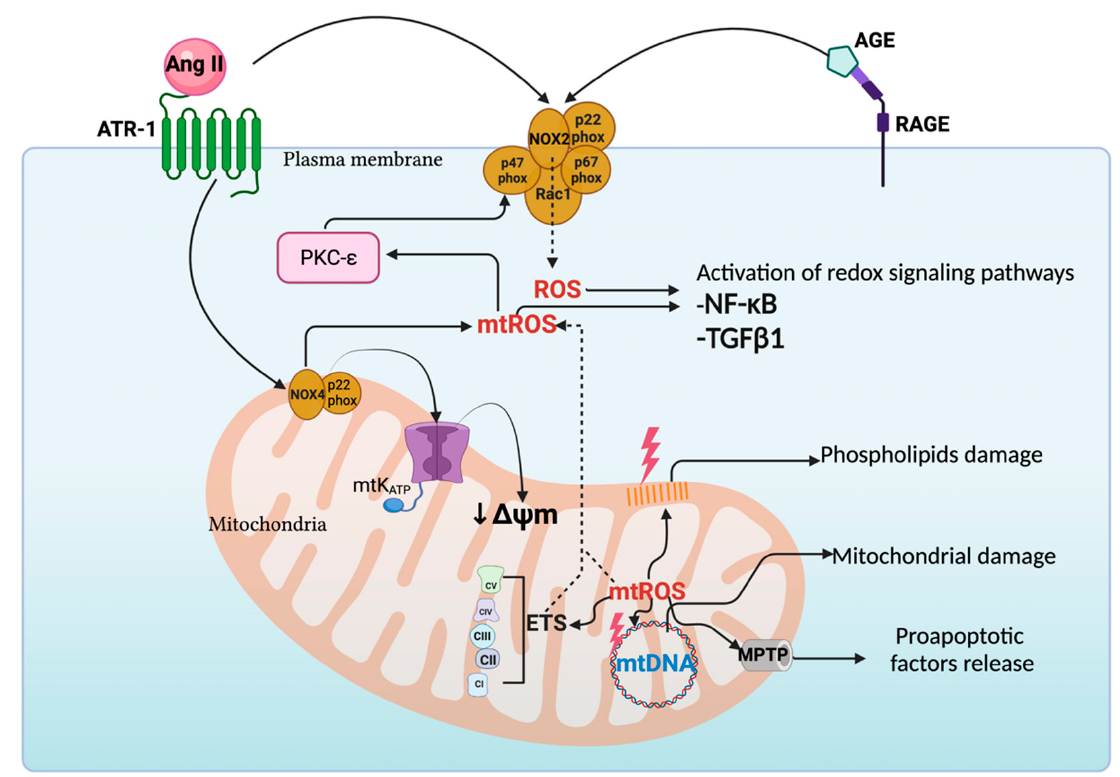
Figure 2. Crosstalk between nicotinamide adenine dinucleotide phosphate (NADPH) oxidases (NOXs) and mitochondria in the kidney. Angiotensin II (Ang II) binds to the angiotensin type 1 receptor (ATR-1), which activates NOX2 and NOX4. In addition, the binding of advanced glycation end products (AGEs) to the receptor for advanced glycation end products (RAGE) induces the activation of NOX2. Furthermore, protein kinase C (PKC) epsilon (PKC- ε ), activated by mitochondrial ROS (mtROS), activates NOX2 through the p47-phox subunit, inducing ROS production. NOXs-induced ROS promote the phosphorylation and opening of an mitochondrial adenosine triphosphate (ATP)-sensitive potassium K channel (mt-K ATP ), decreasing mitochondrial membrane potential depolarization ( ↓ ∆Ψ m). ROS and mtROS activate the redox signaling pathways: transforming growth factor-beta 1 (TGF β 1) and nuclear factor kappa-light-chain-enhancer of activated B cells (NF- κ B). mtROS also affect mitochondrial function by inducing damage to mitochondrial deoxyribonucleic acid (DNA) (mtDNA) and phospholipids that, in the last instance, generates mitochondrial dysfunction. The mtROS also favor the mitochondrial permeability transition pore (MPTP) opening, inducing the release of proapoptotic factors into the cytosol. p67-phox: subunit from NOX2; p22-phox: subunit from NOX2 and NOX4; Rac1: Ras-related C3 botulinum toxin substrate